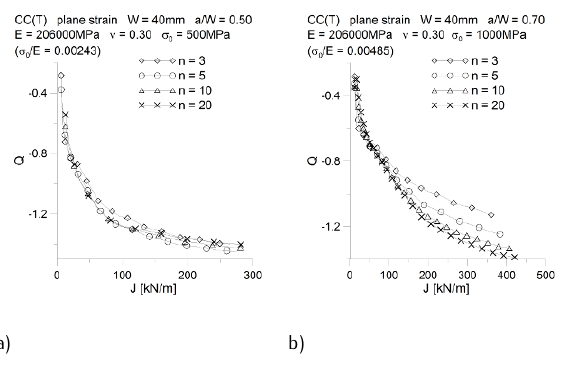
Figure 11. The influence of the work-hardening exponent on J - Q trajectories for CC(T): a) a / W =0.50, σ 0 =500MPa; b) a / W =0.70, σ 0 =1000MPa; (plane strain at distance from crack tip r =2.0 · J / σ 0 ).